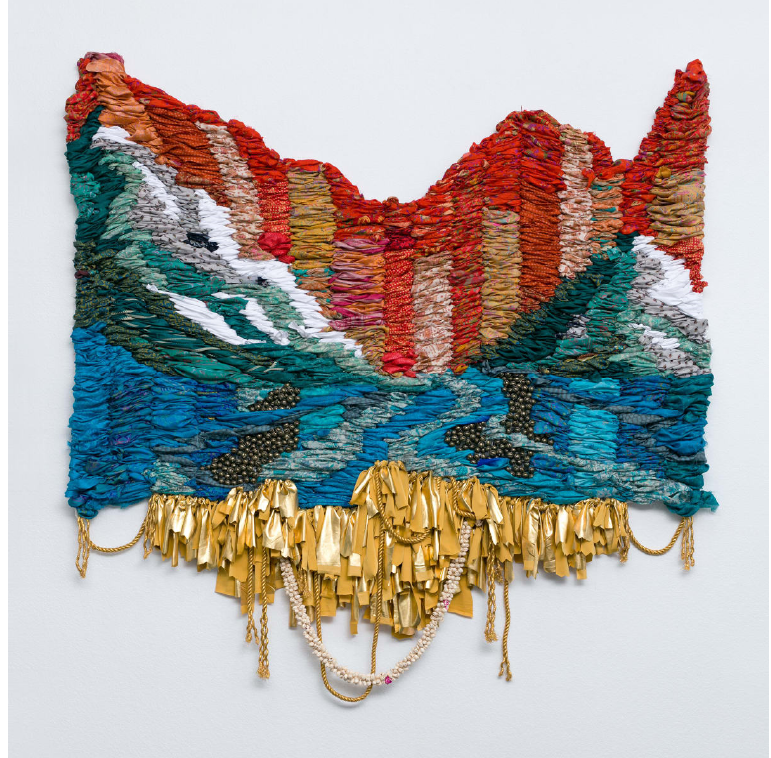
Figure 8. Suchitra Mattai , An Alien Spirit with a Breathtaking View , 2022, vintage saris, fabric, cord, ghungroo bells, and garland, 76 × 80